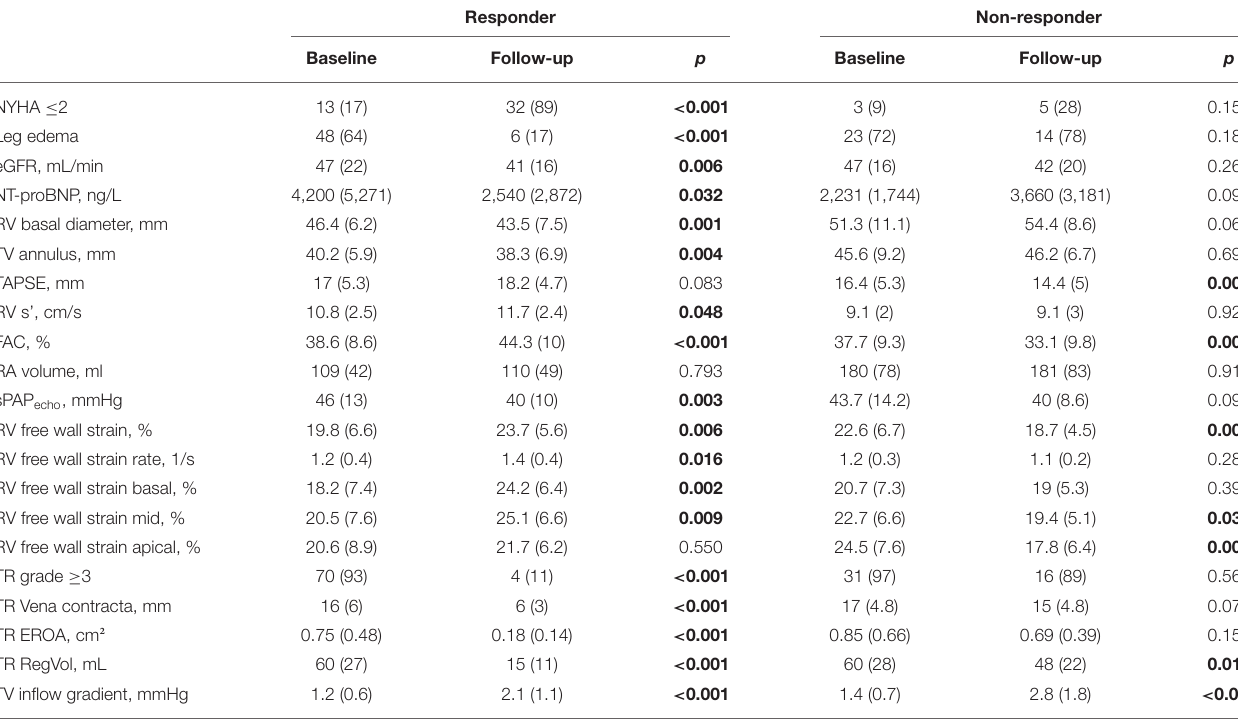
TABLE 4 | Comparison of baseline and follow-up data divided by responder and non-responder.